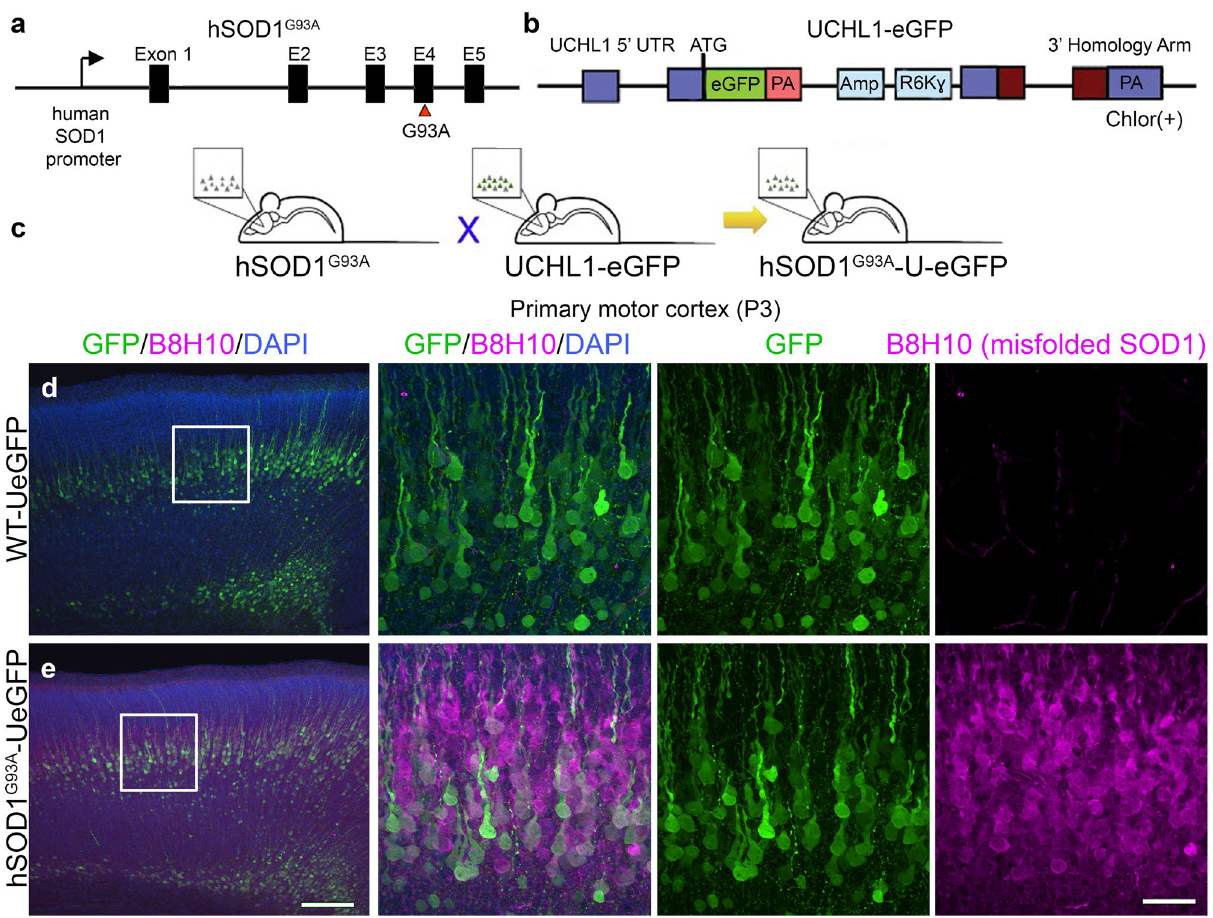
Figure 1. When mixed cortical cultures are established at P3, UMNs are labeled by eGFP expression in UCHL1-eGFP reporter mice, and express disease-causing proteins in reporter lines of mouse models of amyotrophic lateral sclerosis (ALS) ( a-c ) Generation of hSOD1 G93A -UeGFP and WT-UeGFP littermate control mice. ( d-e ) UMNs in layer 5 of the primary motor cortex express eGFP at postnatal day P3 of WT-UeGFP mice. ( e ) B8H10 antibody detects misfolded SOD1 protein in the primary motor cortex of hSOD1 G93A -UeGFP mice, but not the control WT-UeGFP mice at P3. Scale bars = 200 µm in low mag, 50 µm in high mag When dissociated cortical cultures are established at postnatal day P3 46 from WT-eGFP mice, the motor cortex is carefully dissected out from the rest of the brain to increase the percentage of UMNs in culture and to reduce the chance of introducing other eGFP + cells in the brain. UMNs retain their neuronal identity with large pyramidal soma, long axon, and they continue to express neuronal markers such as NF-H and UMN markers, such as Ctip2 8,51,52 (Fig. 2a). In addition, the extent of their cell body can be fully visualized with eGFP expres- sion, allowing detailed cellular assessments. Among many other cells (the blue dots (DAPI) represent nuclei of other cells) and neurons (as marked by NF-H) in culture, only the Ctip2 + , large pyramidal neurons express eGFP (Fig. 2a, Supplementary Fig. S1). The UMN identity of these neurons in the motor cortex were previously established by retrograde labeling, molecular marker expression and electrophysiology 8 . Therefore, we are con- fident that the eGFP + neurons in culture are indeed UMNs. UMNs of WT-UeGFP mice (Fig. 2b) extend axons with an average length of 321.41 ± 17.54 μm (n = 119 neurons from n = 3 mice), whereas diseased UMNs of hSOD1 G93A -UeGFP mice (Fig. 2c) extend a significantly shorter axon of 227.62 ± 19.63 μm (n = 122 neurons from n = 3 mice) vs. WT-UeGFP p -value = 0.024 (Fig. 2d, Sup- plementary Table S1). Investigation of dendritic branching/arborization of WT-UeGFP and hSOD1 G93A -UeGFP UMNs using Sholl analysis revealed a significant difference between 100 and 225 µm radius distance from soma, meaning not only the axon length but also the branching patterns can be used as a measure of UMN health. The average axon length (Fig. 2d-e) and Sholl analysis (Fig. 2f, Supplementary Table S2) for WT-UeGFP and hSOD1 G93A -UeGFP mice are significantly different by these two measures. Because average length of axon and the extent of neuronal branching/arborization serve as a quantitative outcome measure to distinguish healthy and diseased UMNs, these two independent parameters are used to assess their cellular response and overall health with respect to compound treatment.